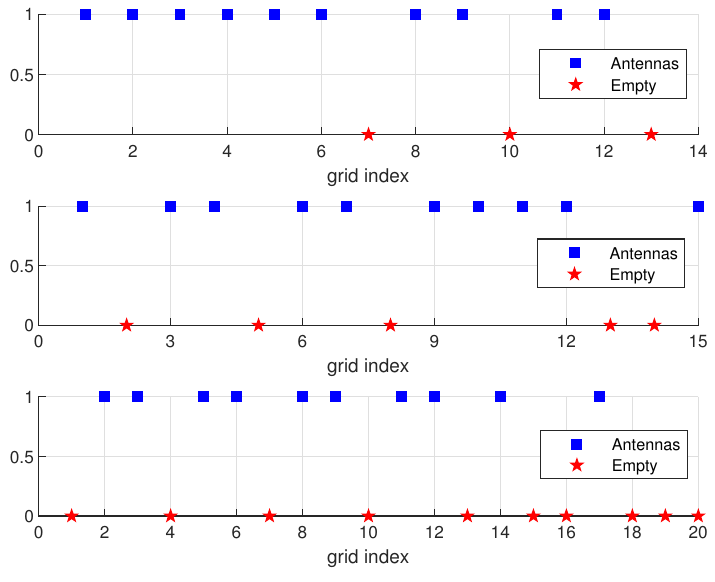
Figure 6. The corresponding sparse antenna positions with M = 10 antennas and a different number of grid